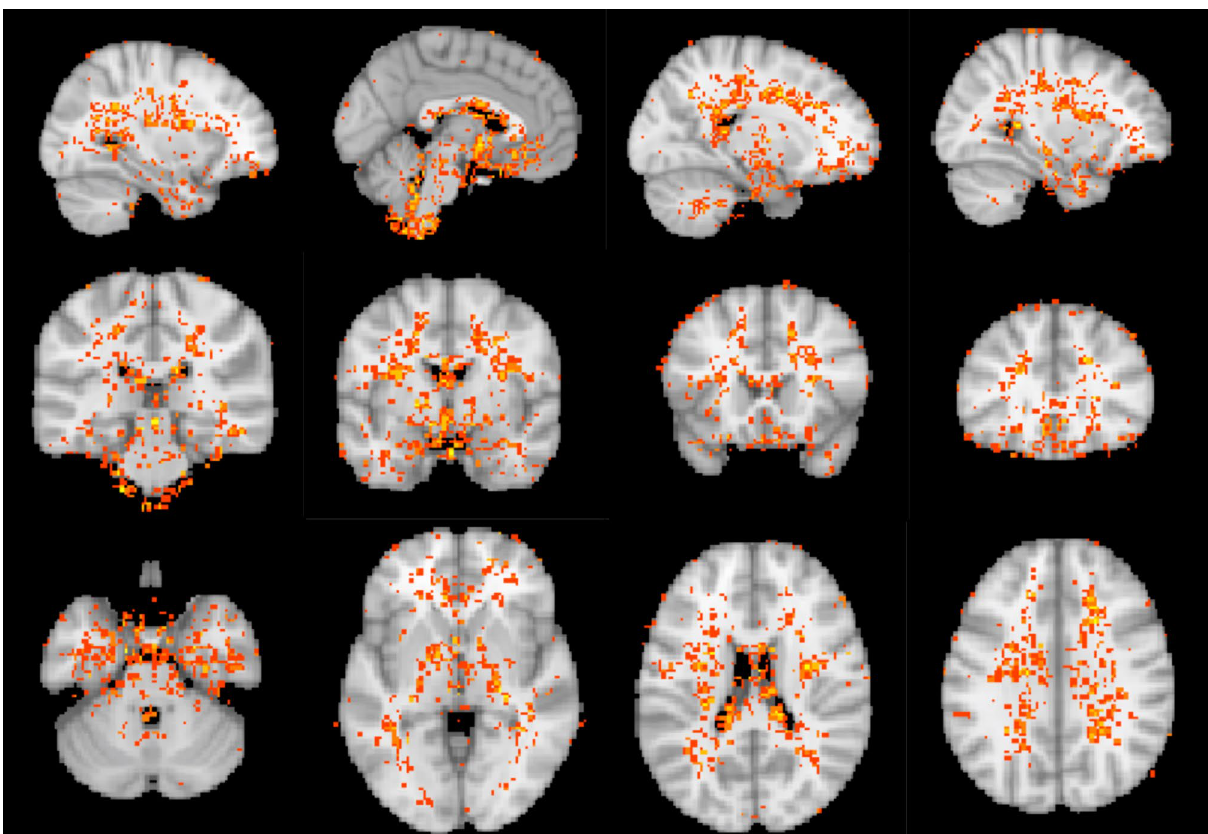
Figure 8. The averaged spatial map of removed voxels with the standard brain as overlay. Voxels that were removed in at least half of the subjects were considered as voxels that were commonly removed among this set of subjects and shown in this